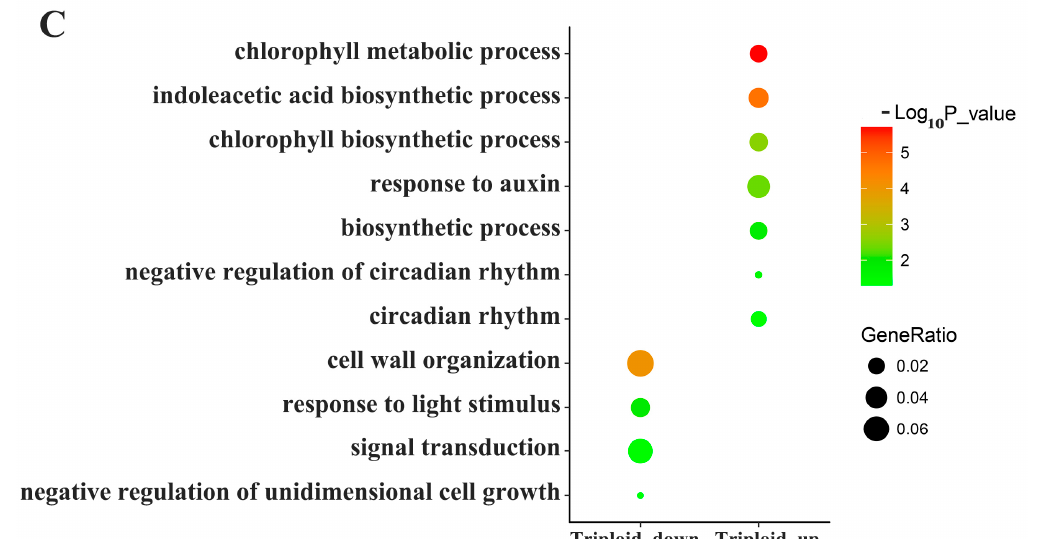
Figure 3. The GO(Gene Ontology databases annotations) terms identified by enrichment analysis for differentially expressed genes. ( A ) Differentially expressed genes at 04:00. ( B ) Differentially expressed genes at 09:00. ( C ) Differentially expressed genes at 21:00. The colors ranging from green to red represents the base 10 logarithm of the enrichment p-value, and the y -axis represents the term of enriched GO terms. The size of the circle indicates the numbers of differentially expressed genes in each GO terms ratio. Up means upregulated genes in triploid; down means downregulated genes in triploid. Table 1. Differentially expressed transcription factors at 04:00.